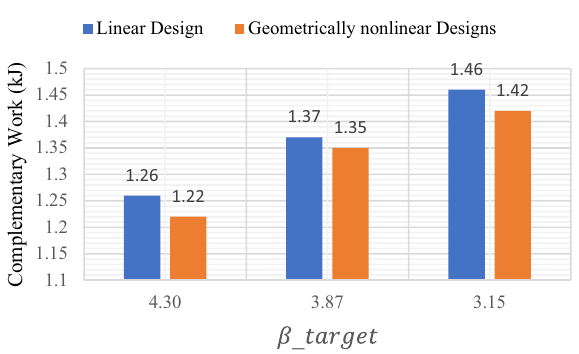
Figure 4. Complementary work values of probabilistic design of the model.